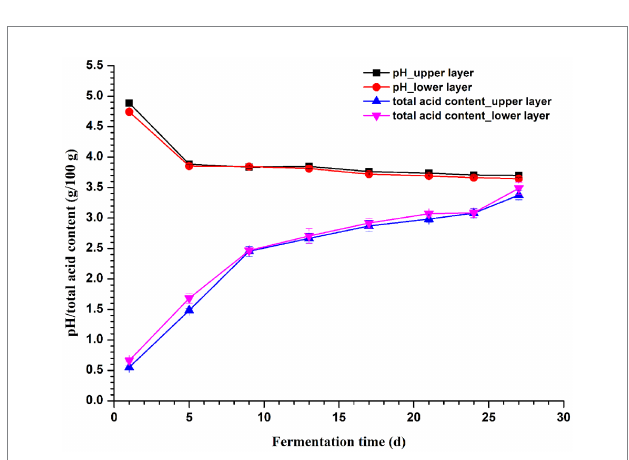
FIGURE 6 Changes in pH and total acid content of vinegar Pei during